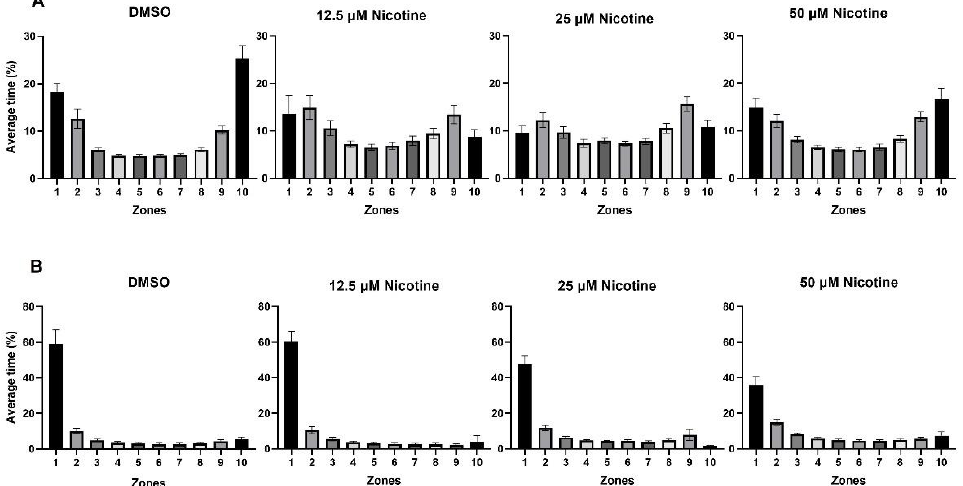
Figure 6. Embryonic nicotine exposure reduces the time fish spend near a live shoal. ( A ) Bars represent the time spent in each of the 10 zones during the first 10 min of habituation and ( B ) the last 10 min of the behavioral session when the stimulus is visible. During habituation, the fish swam back and forth in the tank and spent more time in the zones nearest either end of the tank. During the stimulus, fish from all groups spent more time in zone 1; however, the fish from 50 µM nicotine group spent 23% less time in zone 1 than the control group.